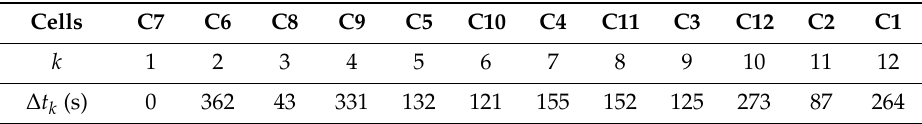
Table 7. Thermal runaway propagation